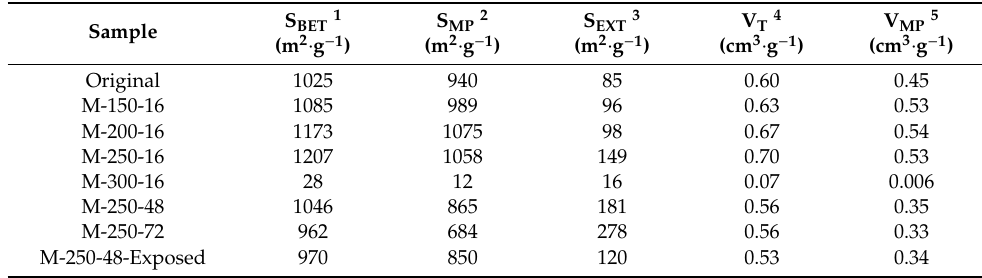
Table 4. Porous texture characterization of NH 2 -MIL-125(Ti) after heat treatment in air under different conditions.